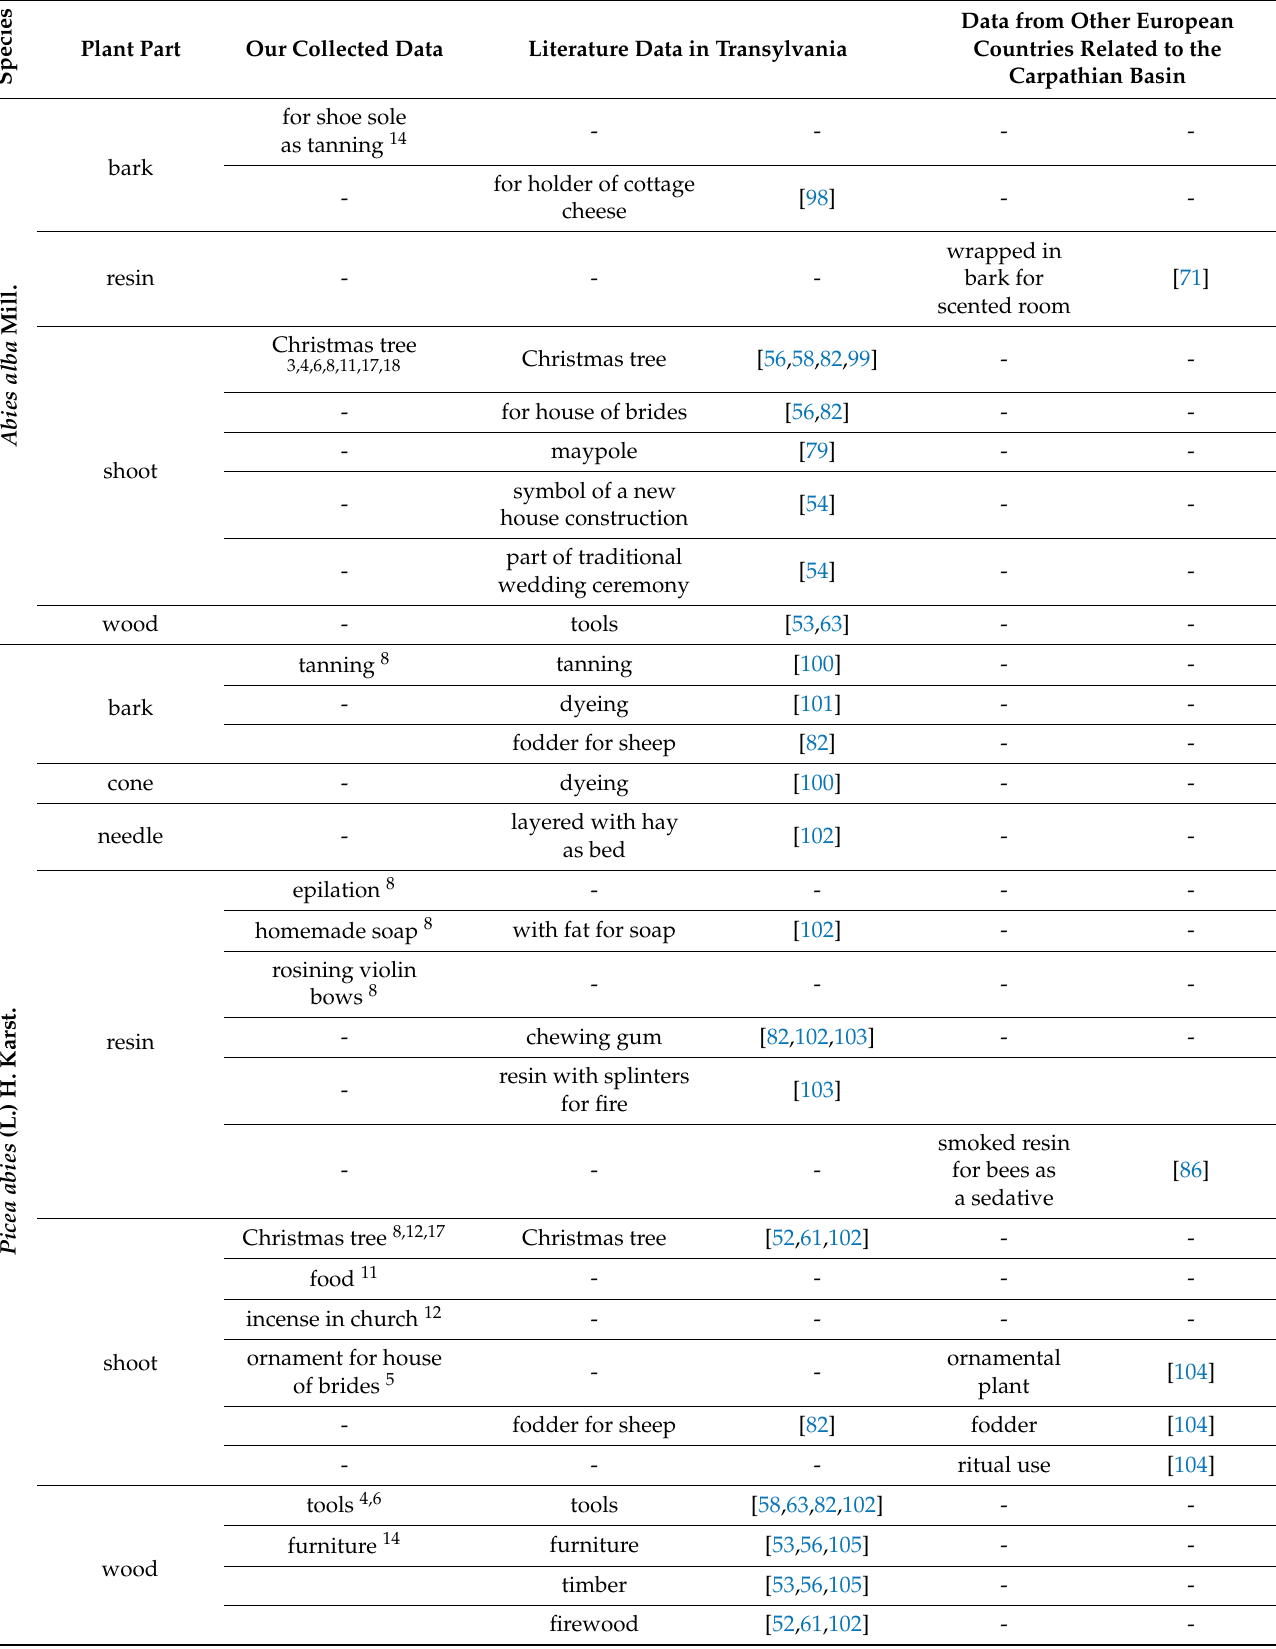
Table 3. Other uses of the pine species in Transylvania compared to literature data from the region and other European countries related to the Carpathian